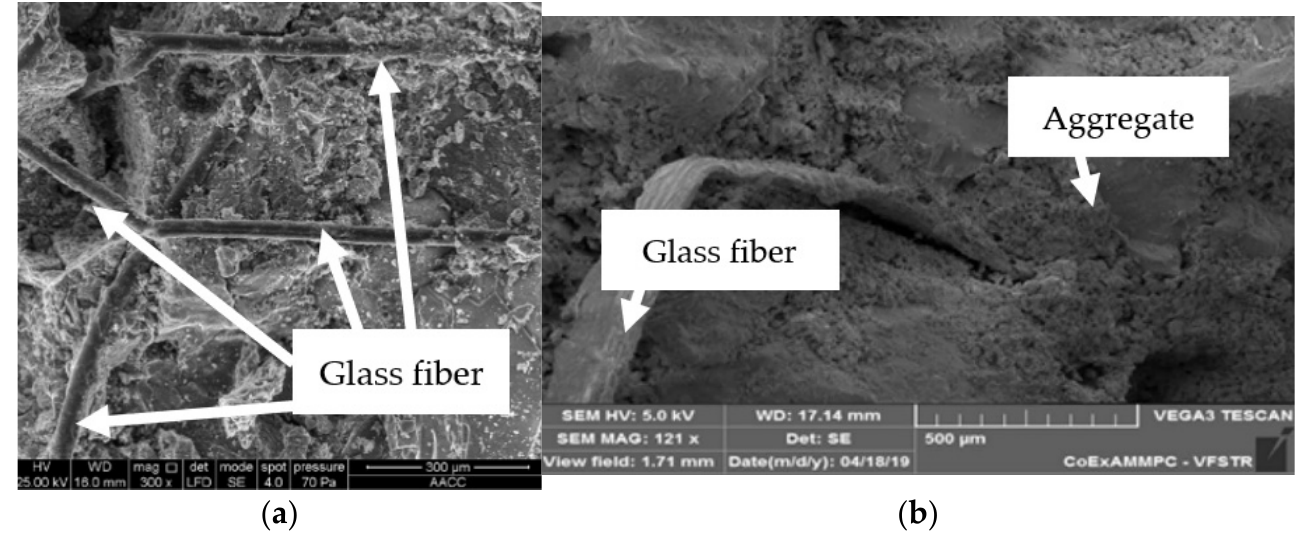
Figure 28. SEM image of GFRC microstructure: ( a ) [116] Adapted permission from Ref. [116]. Copyright 2019 Elsevier; ( b ) [27].